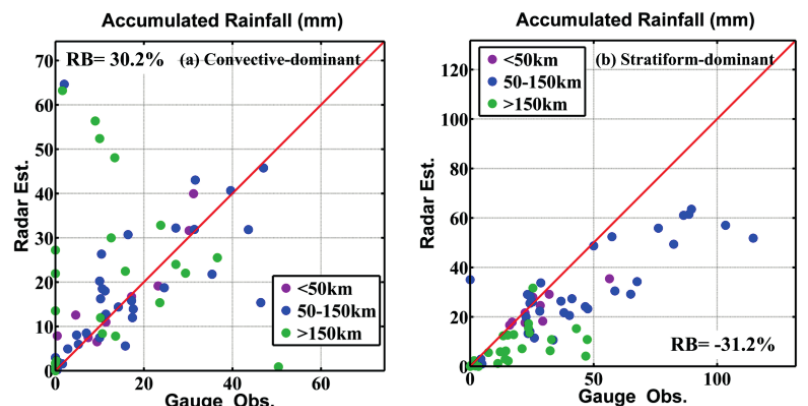
Fig. 4 Gauge observation compared with radar estimates during typical rainstorm events: (a) convective event; (b) stratiform event. RB represents the value of relative bias. Comparison of rainfall estimates at